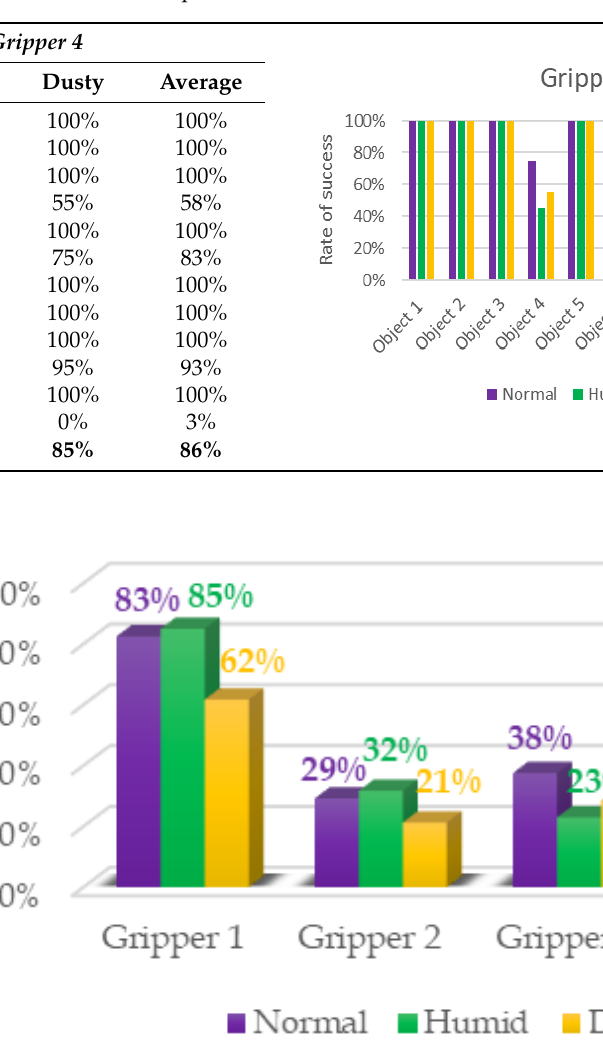
for every object is calculated, and at the end of the table, the average success rate for every environment is determined. On